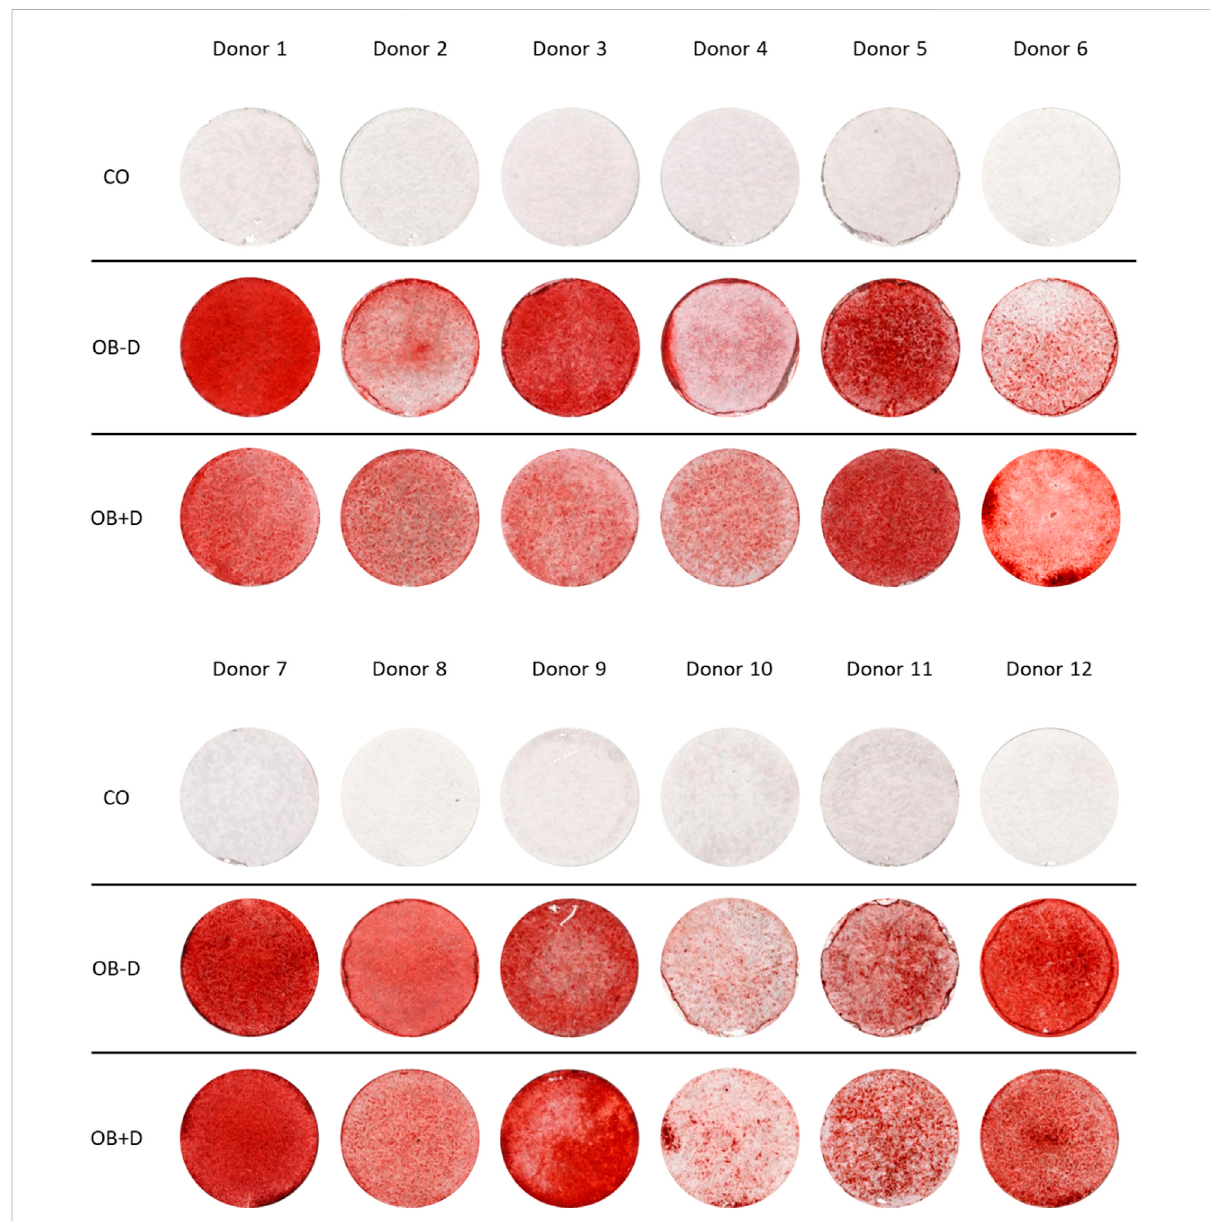
FIGURE 1 Mineralization of JPCs differentiated in vitro with and without dexa. JPCs were cultured for 15 days with control (CO) and osteogenic medium with (OB+D) and without (OB − D) dexamethasone. Calcium phosphate precipitates were detected by Alizarin Red